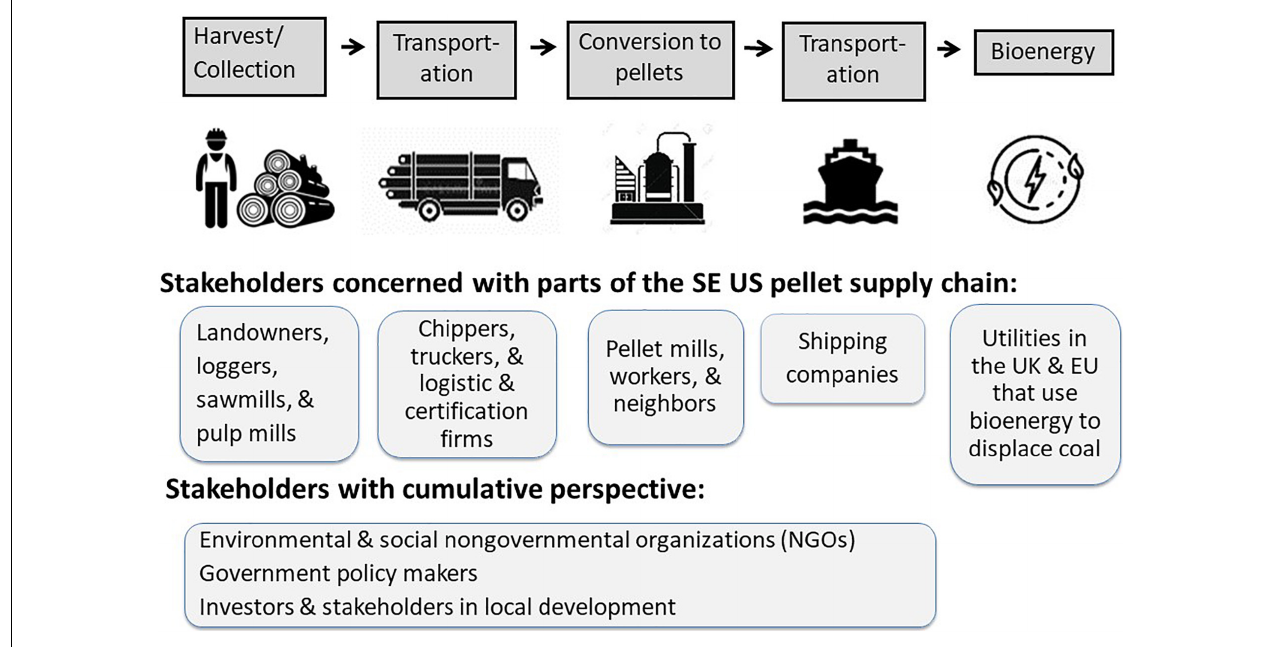
FIGURE 1 | The SE United States woody pellet supply chain and selected stakeholders associated with each step. The risks, resilience, and ultimate effects of COVID-19 on the supply chain and stakeholders can vary by place, sector, or socio-economic group, and over